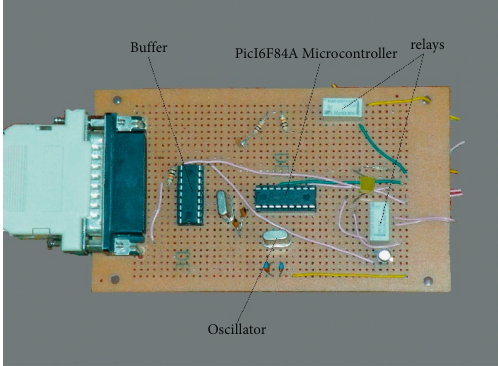
Figure 6: The microcontroller circuit.